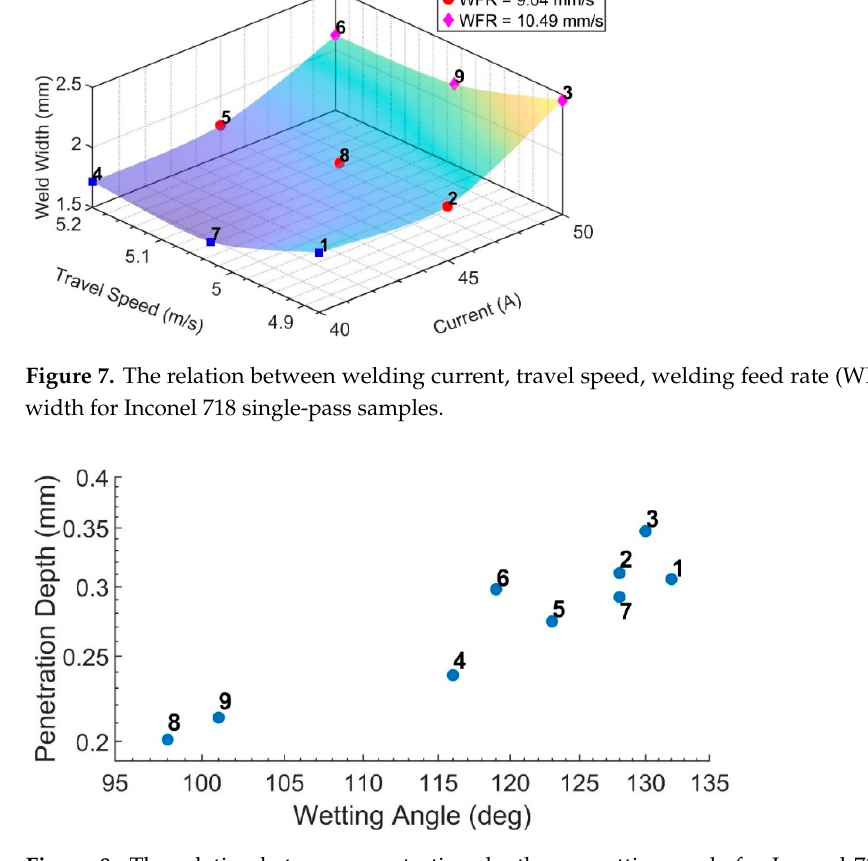
Figure 8. The relation between penetration depth vs. wetting angle for Inconel 718 single-pass samples. The number on the data points indicate the experiment numbers.